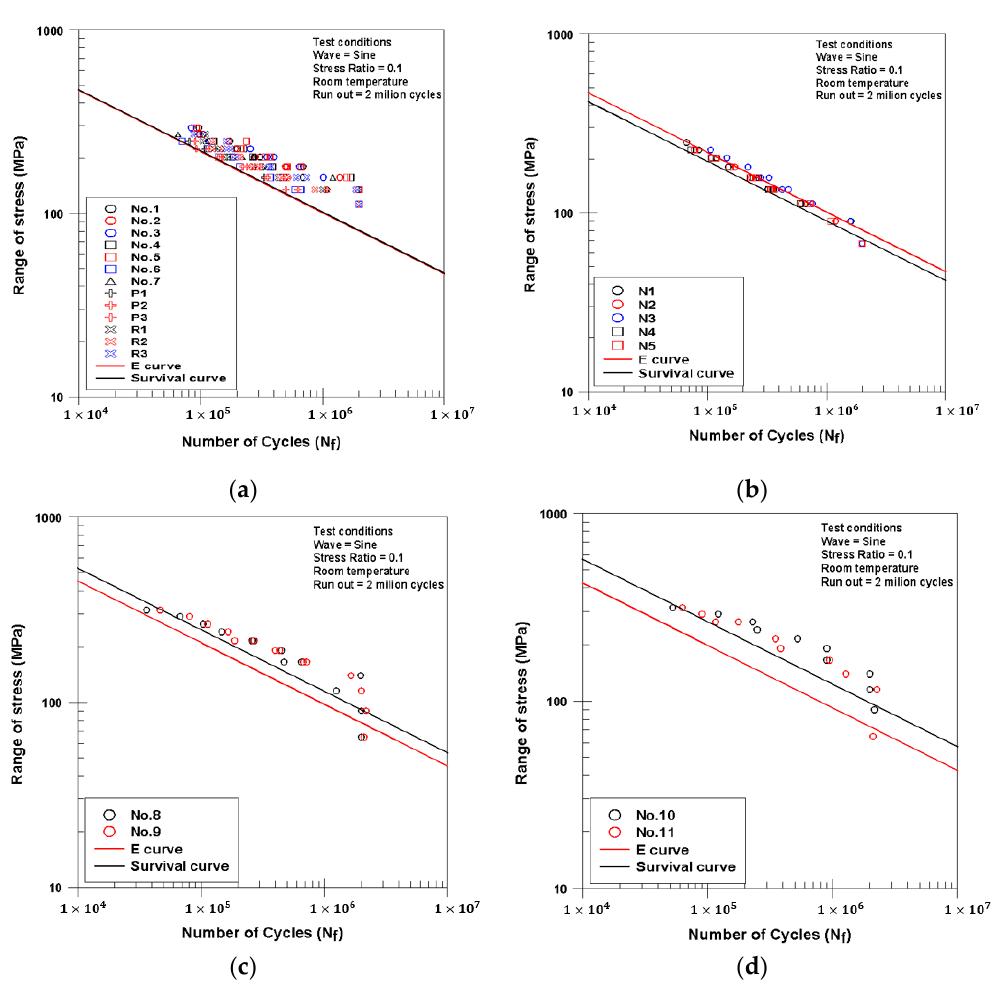
Figure 23. S-N curve for each base material thickness: ( a ) for 20 mm; ( b ) for 25 mm; ( c ) for 30 mm; ( d ) for 40 mm.